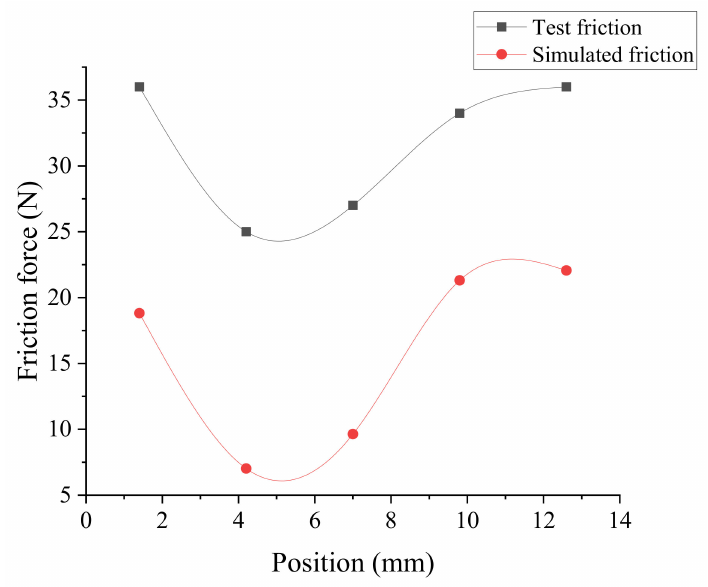
Figure 15. Sealing ring simulates friction and test